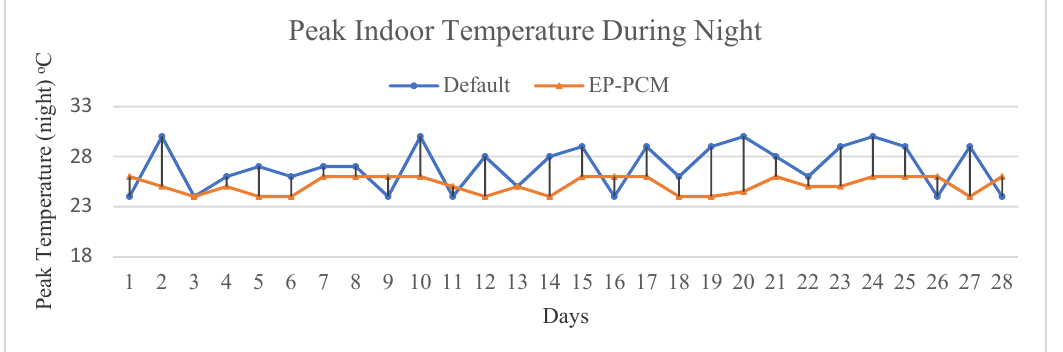
Figure 3. Daily peak indoor temperature of nZEB Living Lab in July 2020.